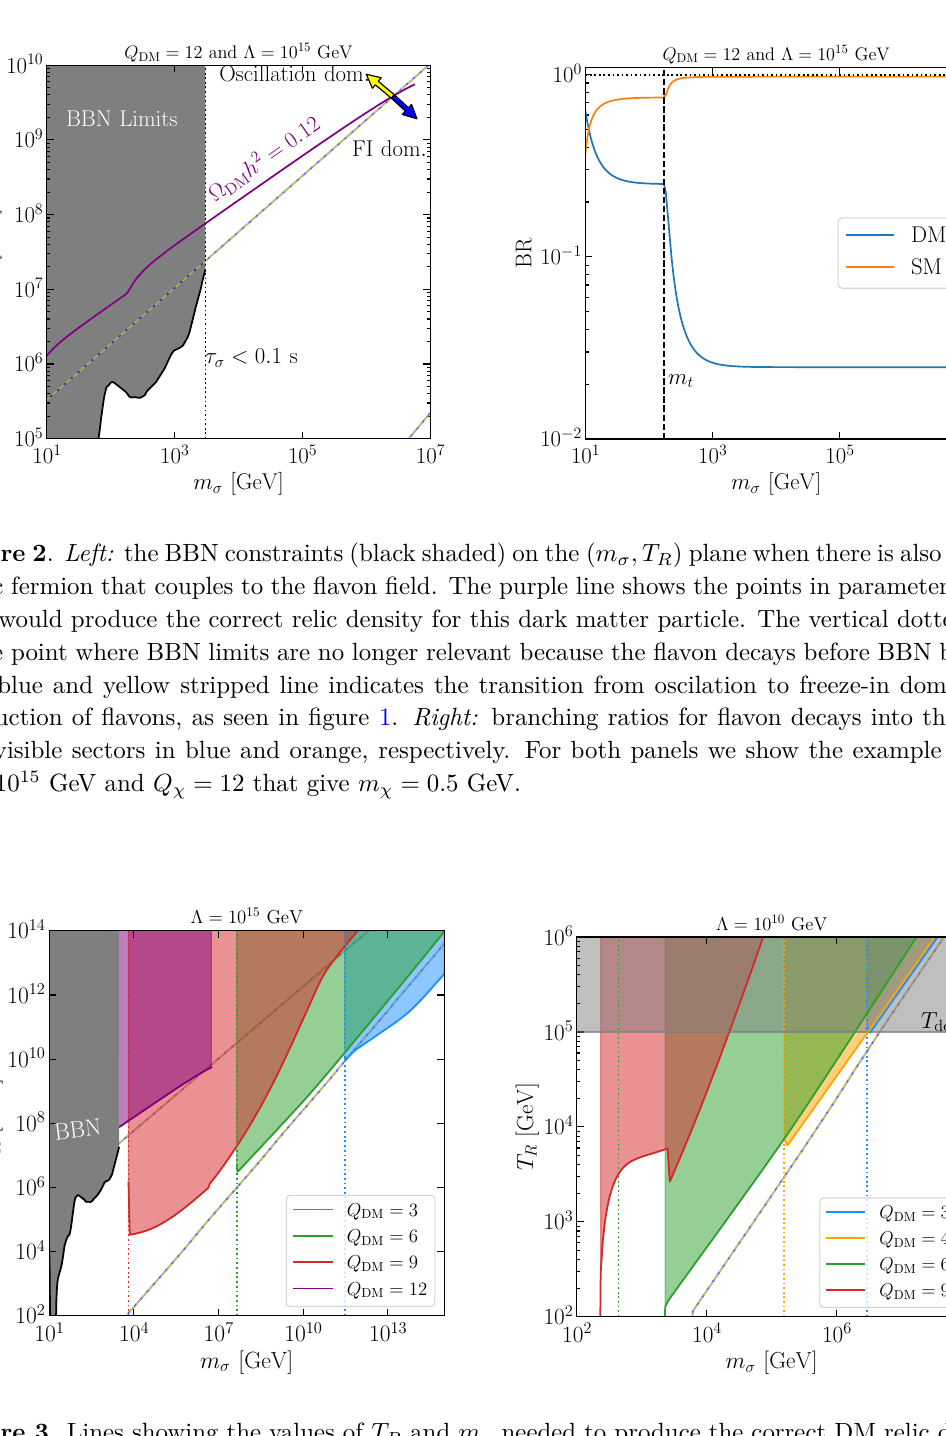
Figure 3 . Lines showing the values of T R and m σ needed to produce the correct DM relic density for charges 3 (blue), 4 (orange), 6 (green), 9 (red), 12 (purple). The lines are taken after BBN constraints have been taken into account. Left: Λ = 10 15 GeV and right: the same but for Λ = 10 10 GeV. We have now shaded the regions where Ω DM h 2 ≥ 0 . 12